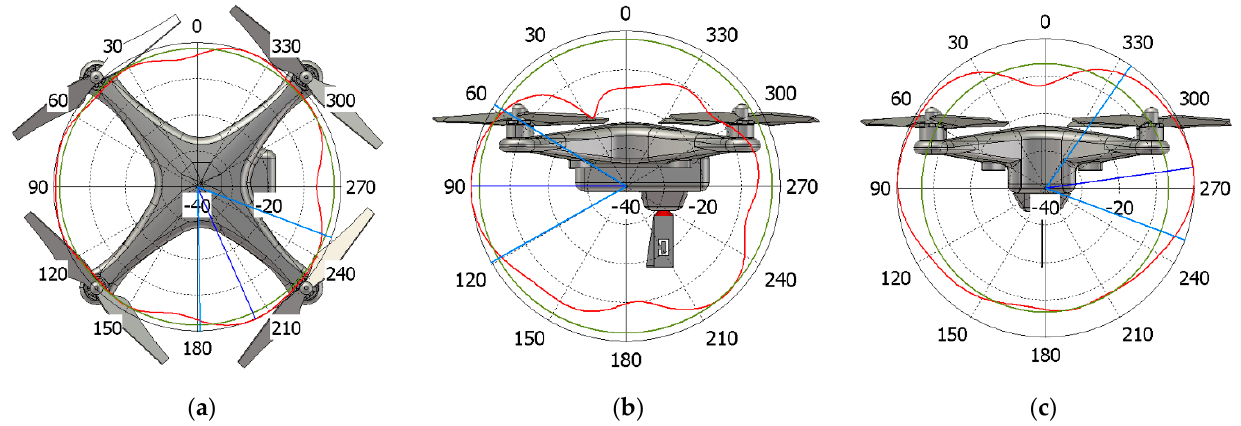
Figure 12. Normalized gain pattern (red line) for DJI Phantom 3 model at 1.09 GHz, ( a ) XY plane, ( b ) YZ plane, and ( c ) XZ plane—CST Simulation Results in dB.